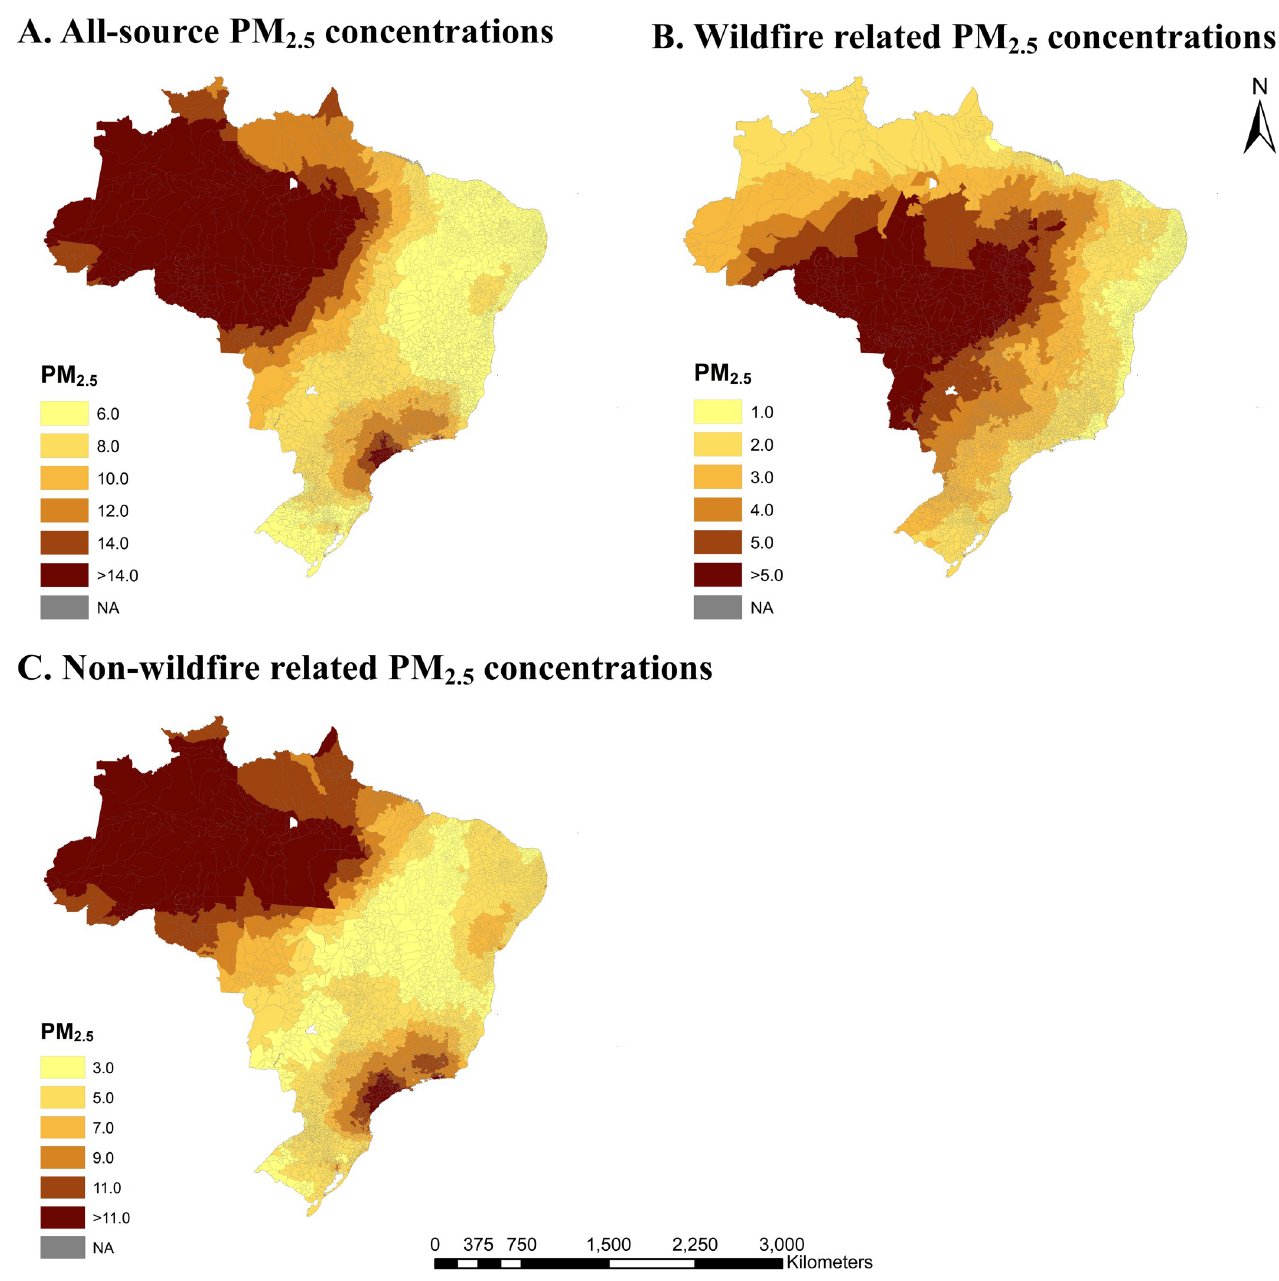
Fig 1. Estimated annual all-source PM 2.5 concentrations, wildfire-related PM 2.5 concentrations, and non-wildfire-related PM 2.5 concentrations for municipalities in Brazil from 2010 − 2016. (A) All-source PM 2.5 concentrations; (B) wildfire-related PM 2.5 concentrations; (C) non-wildfire-related PM 2.5 concentrations. NA, not available. The base map of this figure was downloaded from the Brazilian Institute of Geography and Statistics (https://www.ibge.gov. br/en/geosciences/territorial-organization/territorial-meshes/18890-municipal-mesh.html?edicao=30154&t=downloads); the base map was free and open-